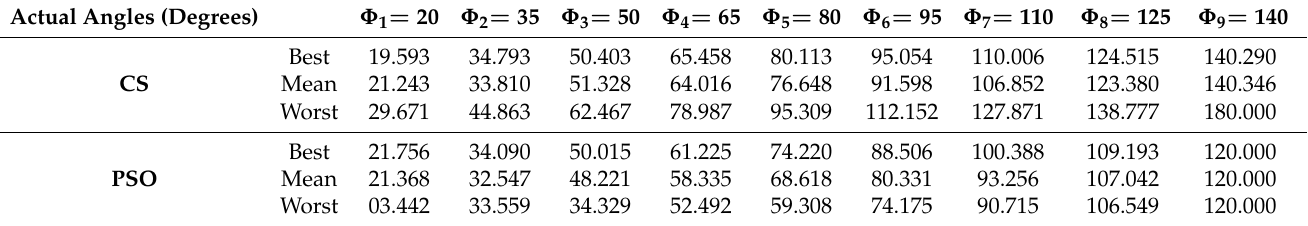
Table 4. Calculation of accuracy for nine targets at 0 dB SNR.